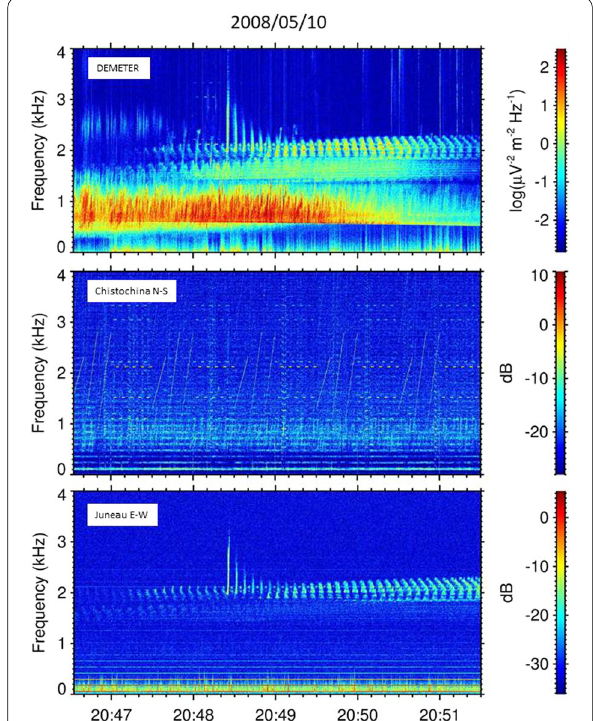
Fig. 21 Spectrograms recorded onboard DEMETER (top panel), at Chistochina (middle panel), and at Juneau (bottom panel) between